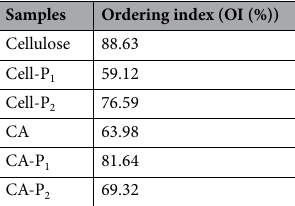
Table 3. Ordering index (OI) for cellulose and its derivatives.